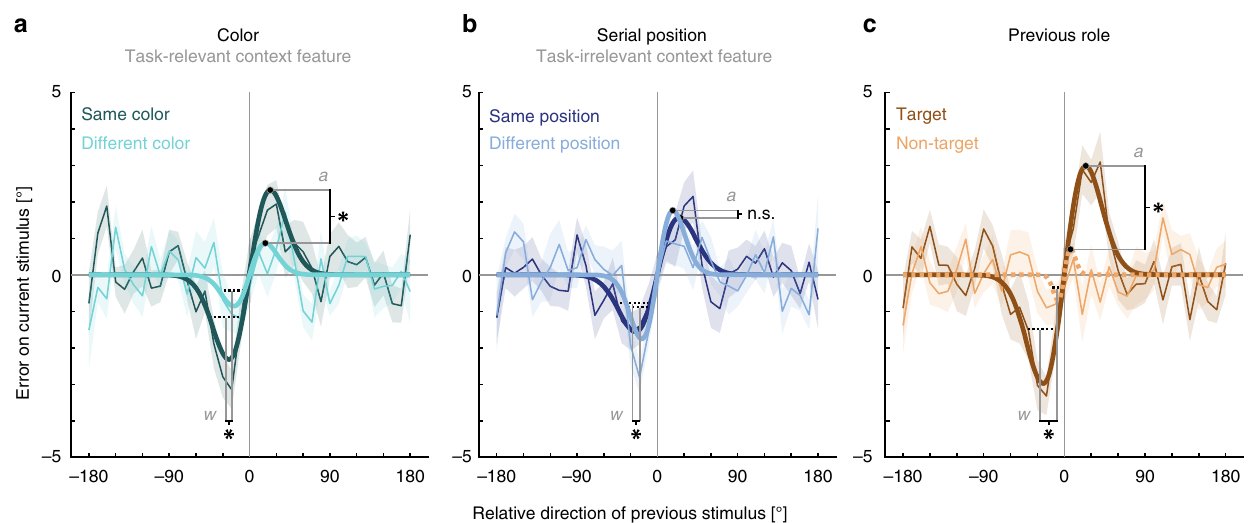
Fig. 2 Results of Experiment 1. The response errors (ordinate) are shown as a function of the motion direction difference (abscissa) between an item of the previous trial and the target of the current trial. Positive values on the abscissa indicate that the target direction was shifted counter-clockwise relative to an item of the previous trial. Positive values on the ordinate indicate that the response direction deviated clockwise from the true target direction. Serial dependence was revealed by the group averages of response errors (thin lines), with the corresponding shaded regions depicting the standard error of the group mean. A derivative of Gaussian (DoG, model fi t shown as bold lines) was fi tted to the response errors to estimate the systematic response bias. Solid lines indicate a signi fi cant bias, whereas dashed lines depict a non-signi fi cant bias Black fi lled circles and black dashed lines are showing the amplitudes and FWHMs of the DoG fi ts and are accompanied by a symbol indicating the result of the direct comparison of the parameter estimates (one-sided permutation tests, 20 participants). Asterisks indicate a p -value< 0.05 and the label ‘ n.s. ’ indicates a non-signi fi cant result with a p -value ≥ 0.05. a Both amplitude and width of serial dependence were greater between items with the same color than between items with different colors (amplitude difference: p < 0.001 , width difference: p = 0.047 ). b The width of serial dependence was greater between items with the same serial position than between items with different serial positions (amplitude difference : p = 0.239 , width difference: p = 0.011 ). c A signi fi cant serial dependence was observed from a target of the previous trial, but not from a previous non-target (amplitude difference: p < 0.001 , width difference: p < 0.001 ). Source data are provided as a Source Data fi